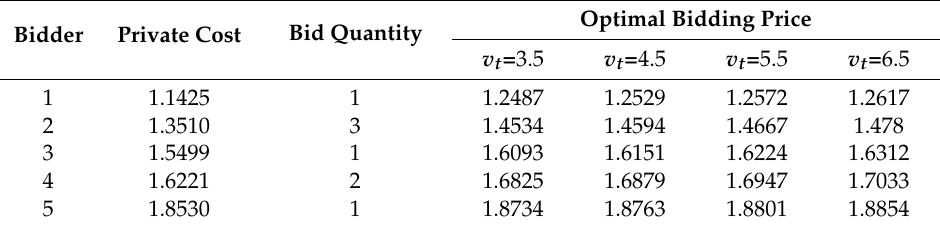
Table 3. Bidding results with different demand